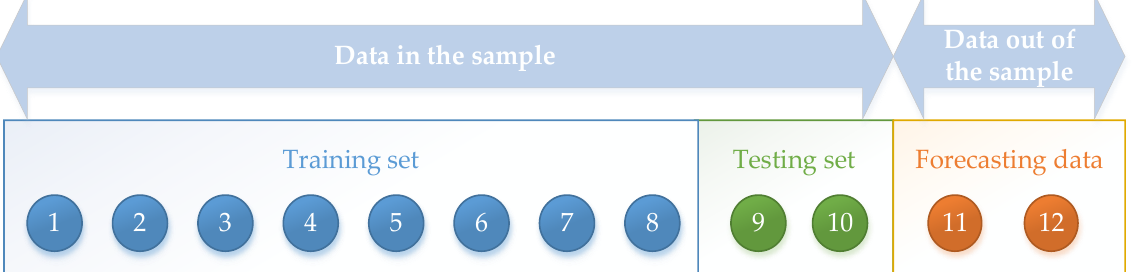
Figure 2. Division of sample data.